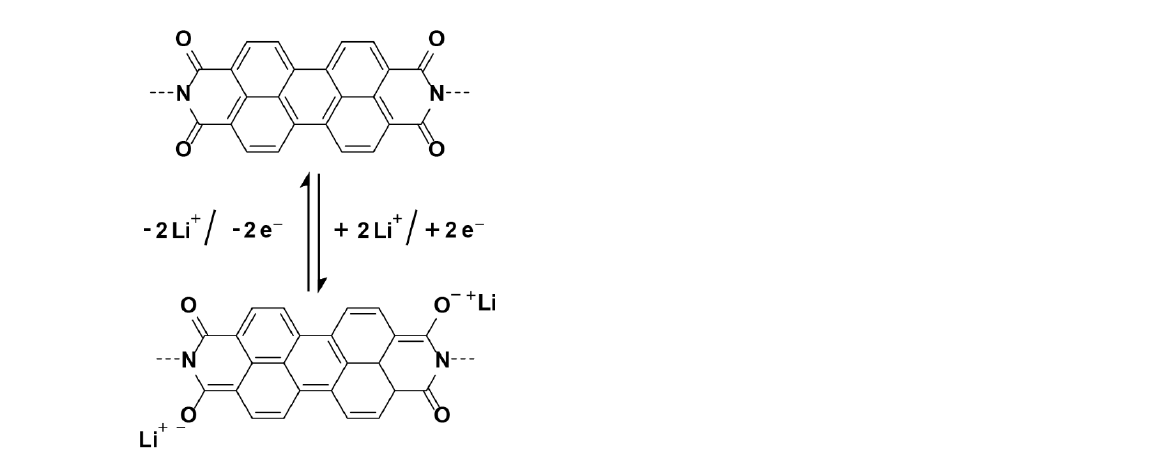
Scheme 2. Faradic reaction mechanism of perylene diimide-based porous polymers with